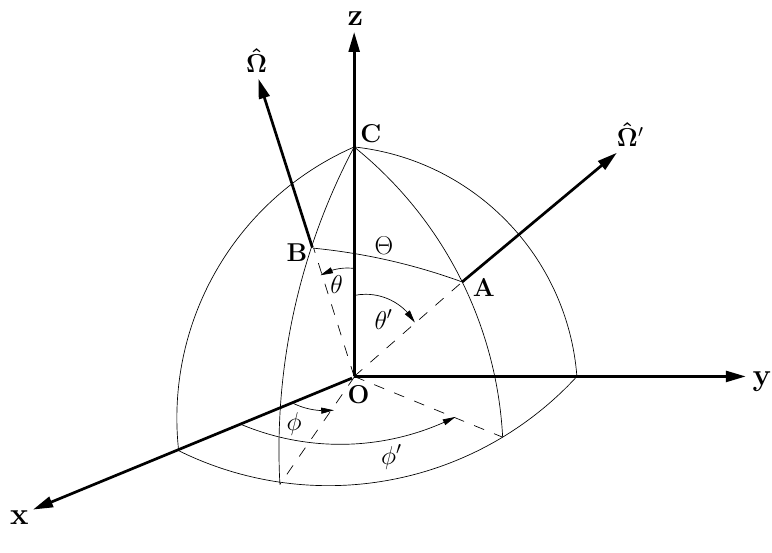
Figure 1. Coordinate system for scattering by a volume element at O . The points C , A and B are located on the unit sphere. The incident light beam with Stokes vector I inc with unit vector ˆ Ω (cid:48) , the scattered beam with Stokes vector I sca ˆ Ω